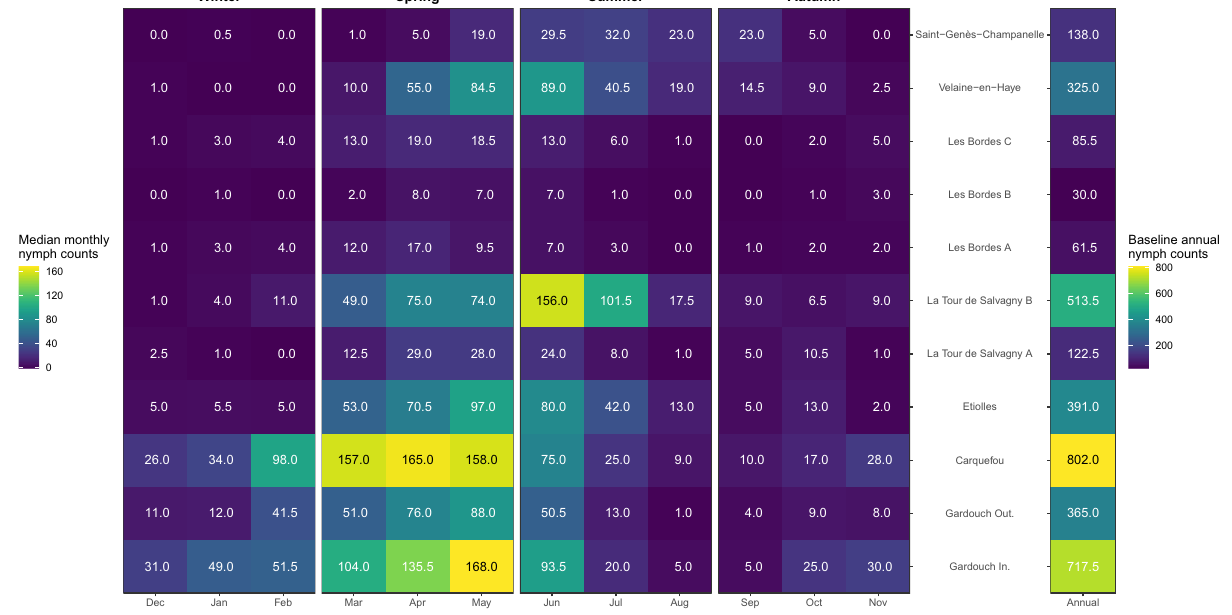
between the 1-month moving average temperature T 0 : 1 M (weather) and the annual average temperature BIO Temp (climate) explained that the nymph counts observed at different climates arrive at peaks at different 1-month moving average temperatures, where nymph counts in warmer climates peaked at lower 1-month moving aver- age temperatures (Fig. 7A). Also, the best-fitted model explained that nymph counts were highest at low previ- ous 3-to-6-month moving average temperatures T 3 : 6 M (Fig. 7B) and high 6-month moving average minimum relative humidity U 0 : 6 N . (Fig. 7C). In addition, it should be noted that because the daytime duration was highly correlated with several meteorological variables, such as 1-month moving average temperature T 0 : 1 M , previous 3-to-6-month moving average temperature T 3 : 6 M , and 1-month moving average minimum relative humidity U 0 : 1 N (Fig. S1); therefore, it was excluded from the best-fitted model. The Dimension-1 PCA coordinates Dim 1 , representing the forest and land cover characteristics of different sampling sites, markedly reduced the variance of random intercepts from 1.0004 in Model 4 to 0.4224 in Model 5 (Table 2). Thus, the forest and land cover characteristics in Model 5 significantly explained model intercepts which indicates their impacts on the baseline nymph count levels. The landscape that supports more baseline nymph counts was suggested to have a moderate percentage of forest-covering areas p Forest , number of forest patches n Forest , and Shannon’s diversity index for level-1 ( H CLC 1 ) and level-2 CORINE Land Cover types ( H CLC 2 ) (Fig. 7D). It should be noted that the Dimension-2 PCA coordinates Dim 2 , driven mainly by the mean and stand- ard deviation of the elevation above sea level, was not significant and therefore not included in the final model. Finally, the prediction from the best-fitted model replicated well the phenological patterns of observed I. ricinus nymphs (Fig. 6 and Fig. S8), particularly sampling sites with more observations, i.e., Saint-Genès-Cham- panelle, Velaine-en-Haye, Etiolles, Carquefou, Gardouch Inside, and Gardouch Outside. However, the autumn peaks of the phenological Pattern 2 (Fig. 6) and the interannual variations of the nymph counts (Fig. S8) remain imperfectly predicted by the model using meteorological variables. Discussion The variations in tick activity across space and time can be classified into four levels: (1) baseline abundance vari- ation; (2) sub-daily variation; (3) seasonal variation; (4) inter-annual variation. The baseline abundance reflects the suitability/carrying capacity of the habitats for the populations, both land cover and climatic conditions 19 . The sub-daily variation arises from the immediate responses of questing ticks to rapid microenvironment changes, such as local temperature, relative humidity 51 , solar altitude, or presence of dew drops, to maintain their water balance 52 . Such responses reflect the instantaneous probability of questing. While seasonal and inter-annual vari- ation reflects the long-term cumulative results of the questing behaviour as well as reproduction, development, and mortality rates on the tick population 3 . However, previous studies on the effects of the environment on I. ricinus nymph activities in Europe did not capture all the aforementioned levels of variation. They largely focused on either a short-term period for multiple sites 21–24 or a long-term period for a few areas 14–17 . The present study attempted to explore the baseline abundance, seasonal, and inter-annual variations of I. ricinus nymph activity by expanding the observation across a wide range of geographical/climatic areas over a long period, involving a total